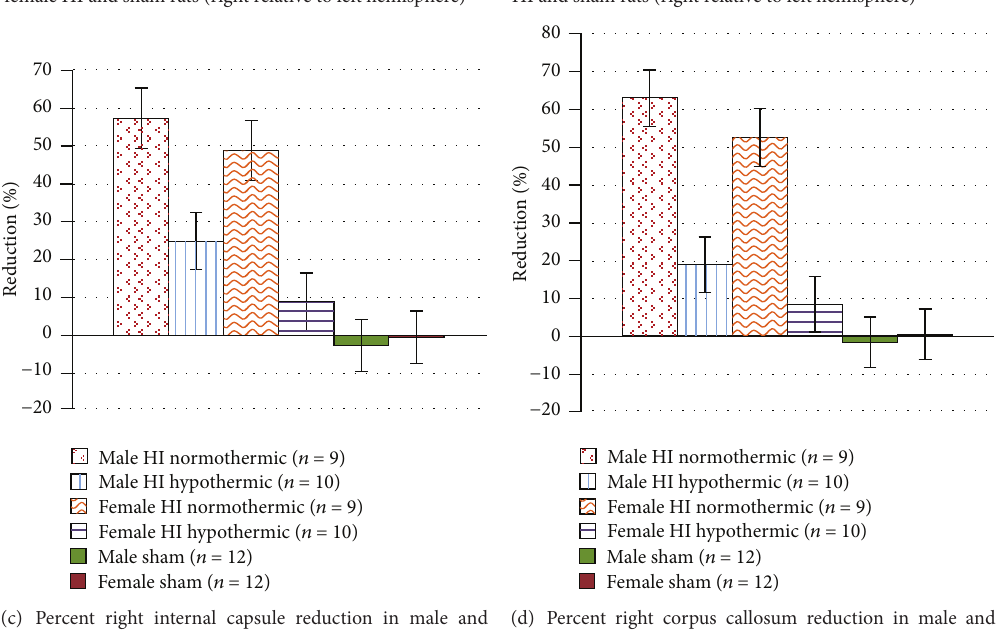
(a) Percent right cortical volume reduction of male and female HI and sham rats (right relative to left hemisphere)